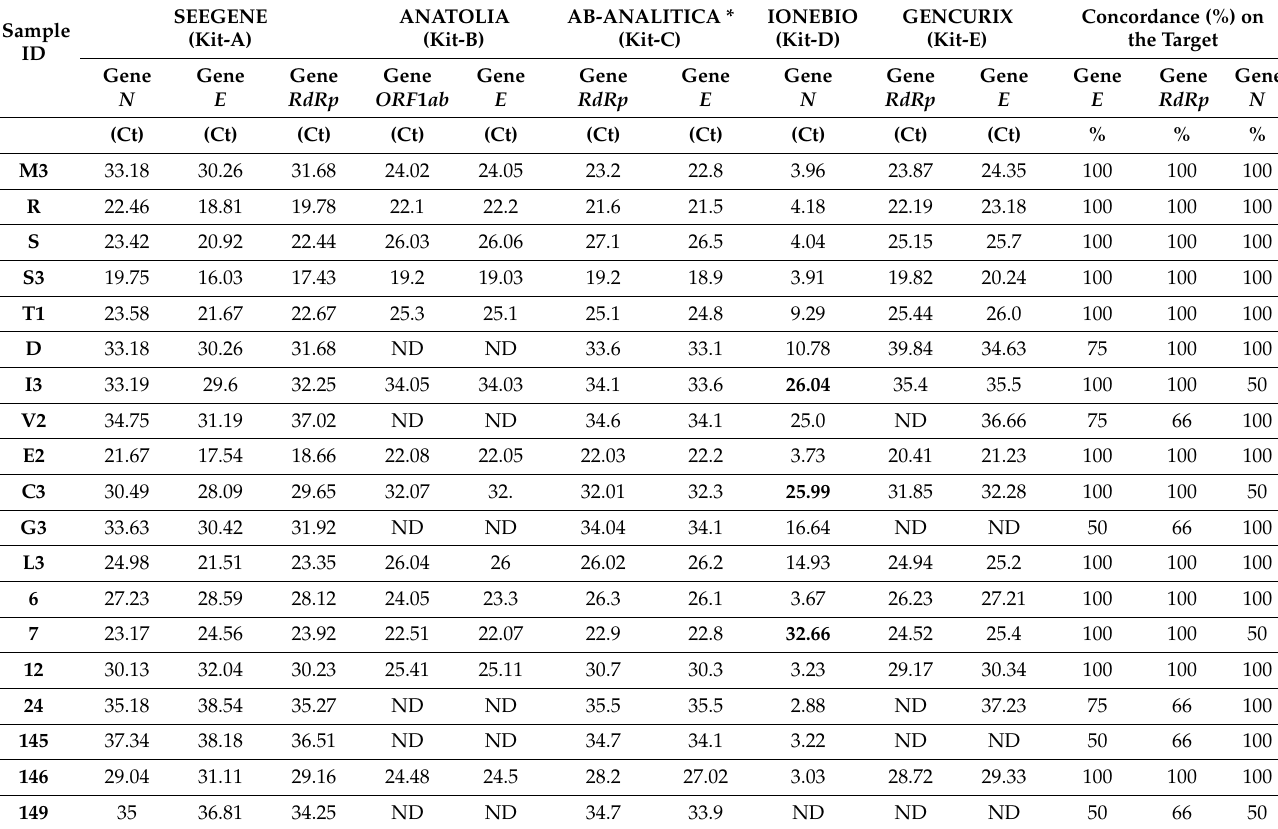
Table 5. Comparisons of the performances of each kit, referring to the different targets detected and reported as the threshold cycle (Ct) in Covid19-positive swabs.